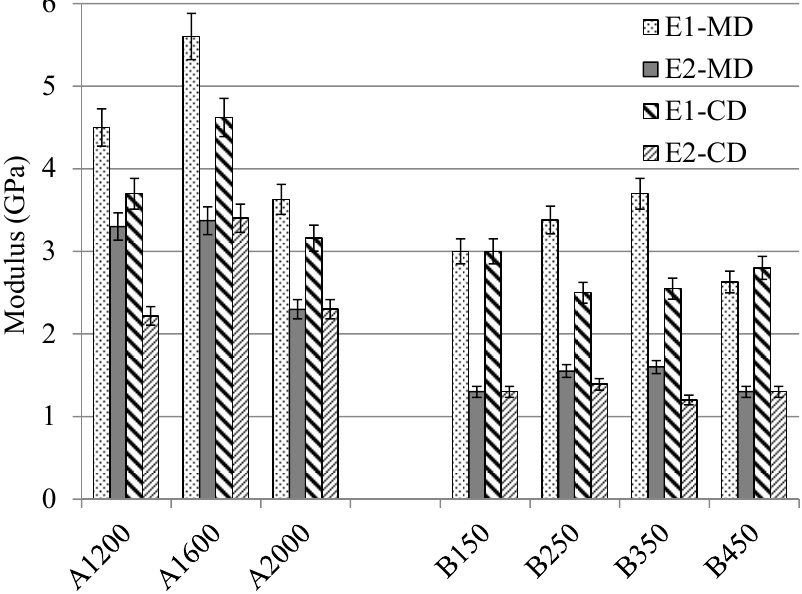
Figure 4. The tensile modulus of A and B nonwoven sets reinforced composites.